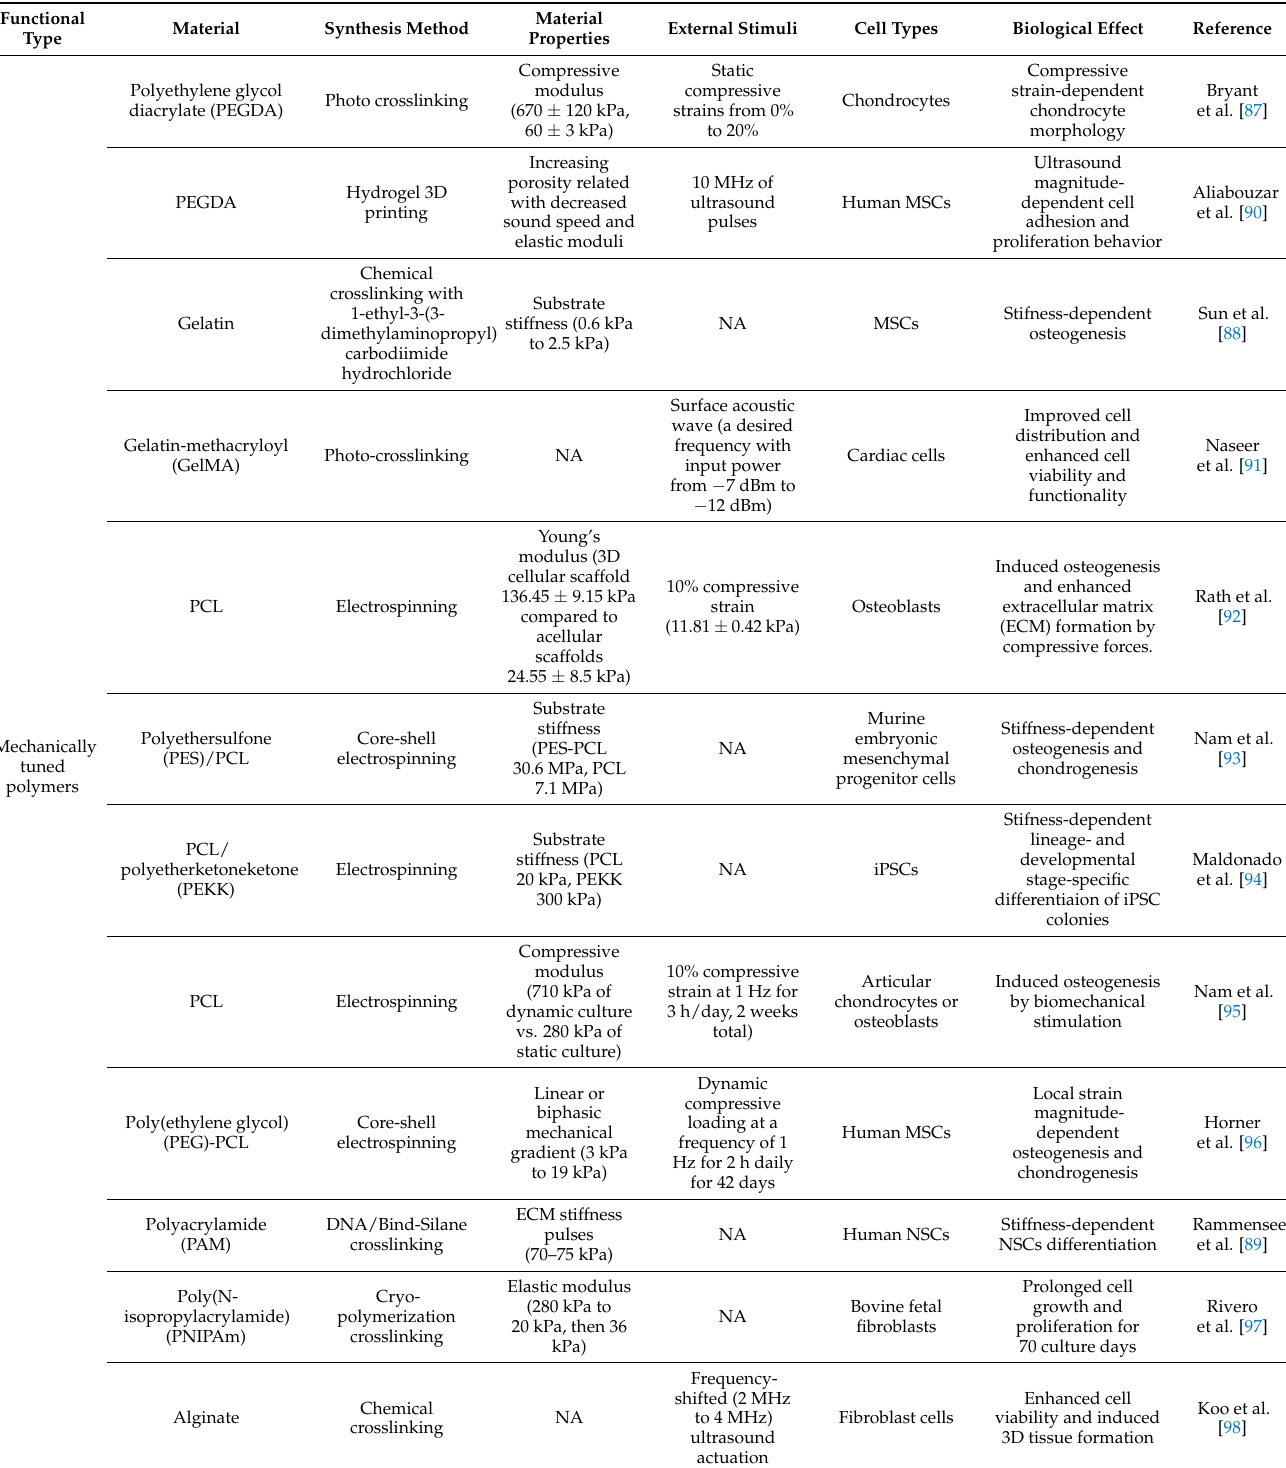
Table 2. Mechanically tuned polymers and their tissue engineering